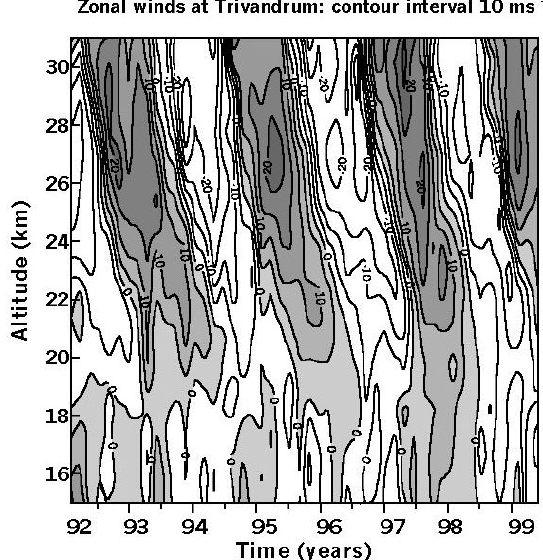
Fig. 2. Height-time structure of the zonal wind ( u ) obtained from balloon data from Trivandrum (8.5 ◦ N, 77 ◦ E) during 1992–1999. The westerly winds are